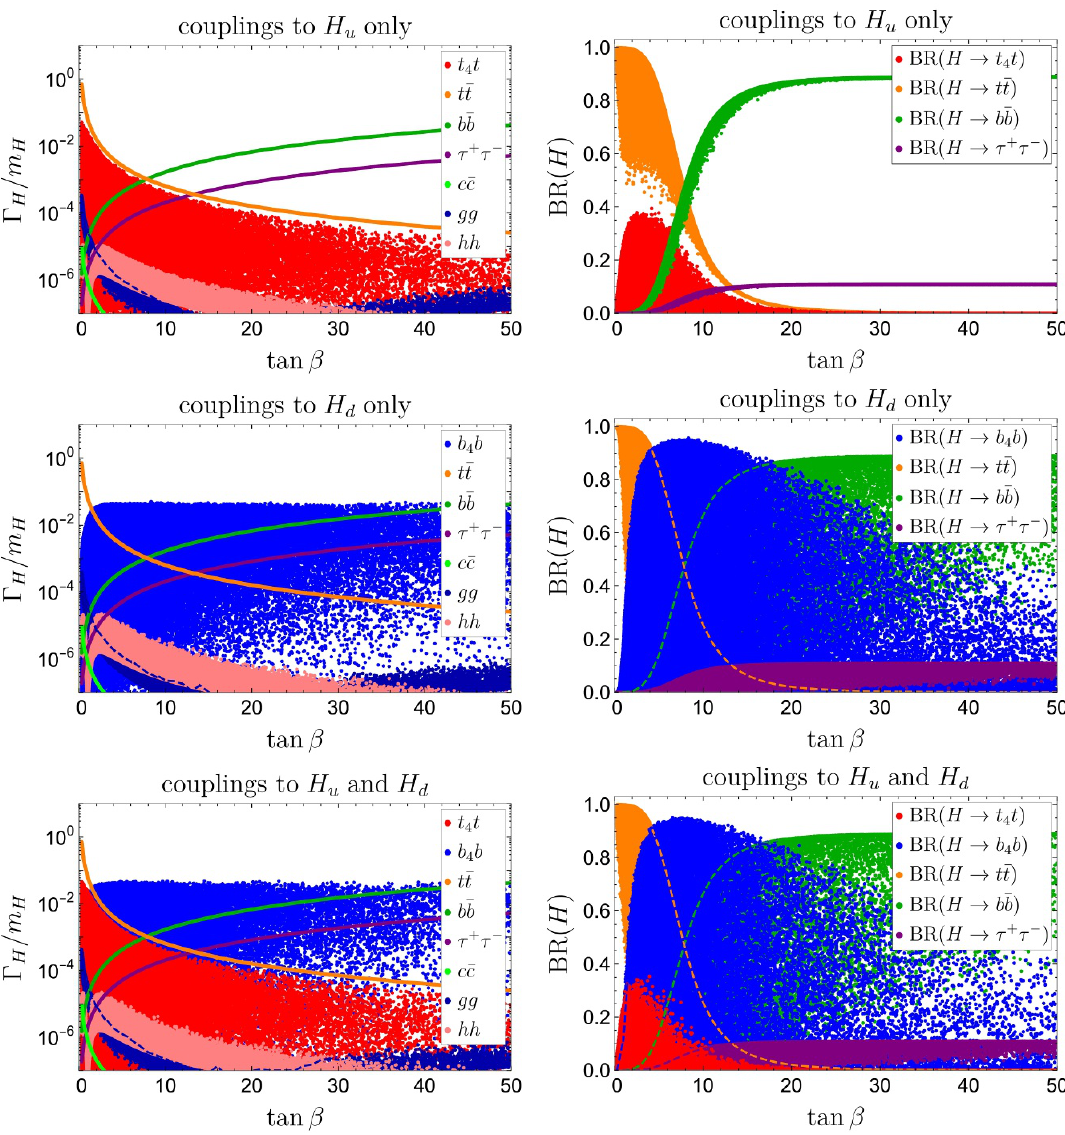
Figure 3 . Partial widths (left) and branching ratios (right) of a heavy neutral Higgs boson as functions of tan (cid:12) assuming couplings to H u only (top), H d only (middle), and H u and H d (bottom).